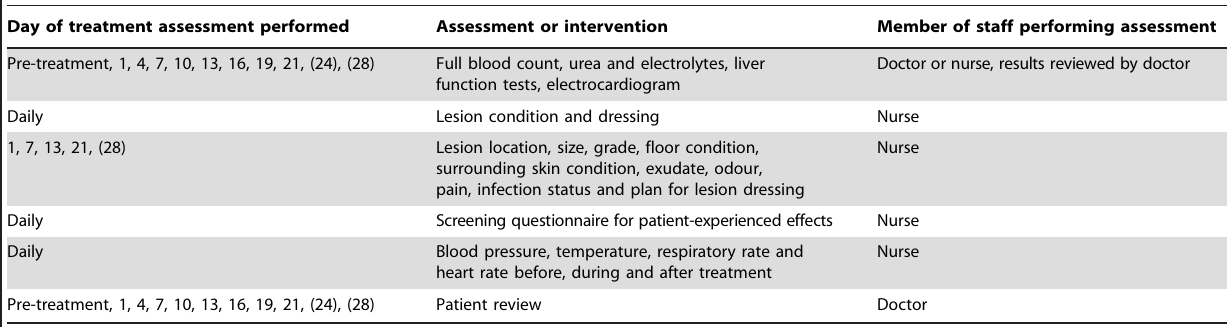
Table 1. The ‘Integrated Care Pathway (ICP)’ framework for patient